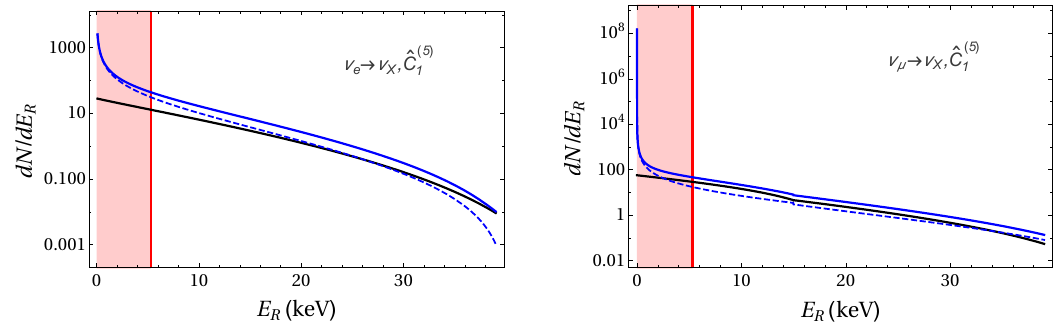
Figure 9 . The ν (left) and ν (right) rates in the COHERENT CsI detector including e → ν X µ → ν X (5) NSI operator contribution, for ˆ C (5) a = 1 / Λ , where Λ is taken to be the corresponding a ;min a ;min 1 Q lower bound in tables 2 and 3, respectively. The SM rate is denoted by the solid black line, dashed blue line denotes the NSI only prediction, and solid blue line the sum of the two. The vertical red line denotes the energy threshold of the